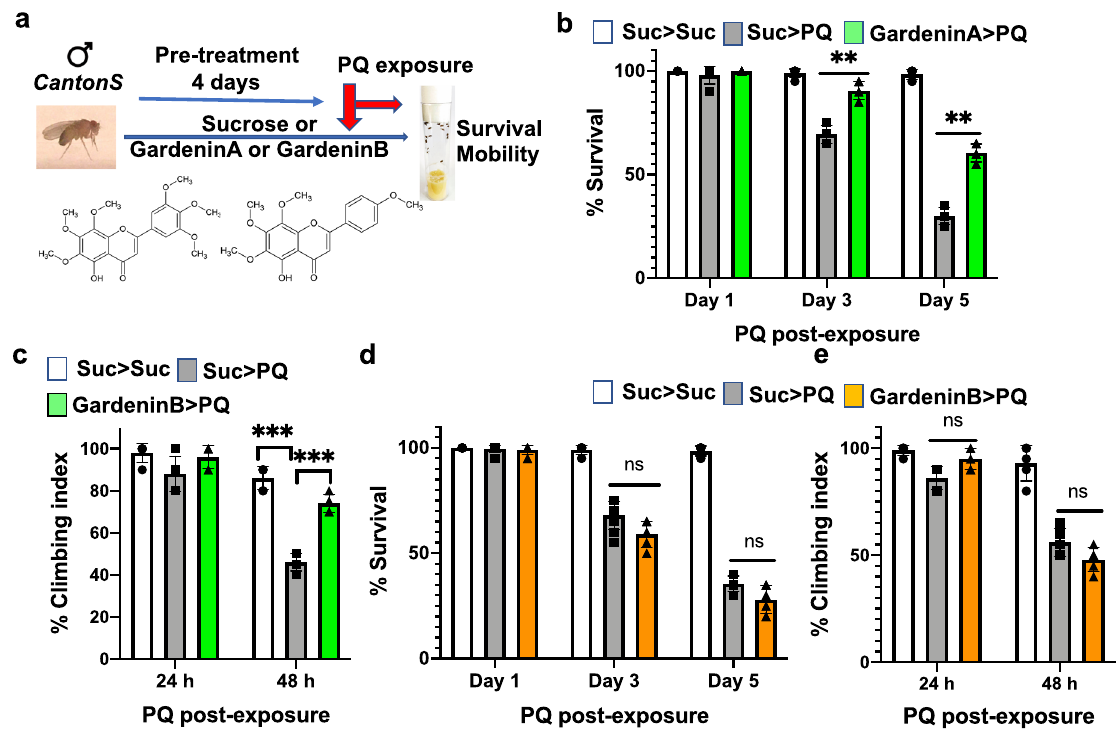
Fig. 1 The protective effects of the fl avonoid, GardeninA against paraquat-induced toxicity and mobility defects. a Schematic representation of the feeding regimen. Adult male fl ies were either pre-fed for 4 days with 2.5% sucrose or GardeninA or GardeninB (10 μ M) followed by continuous exposure